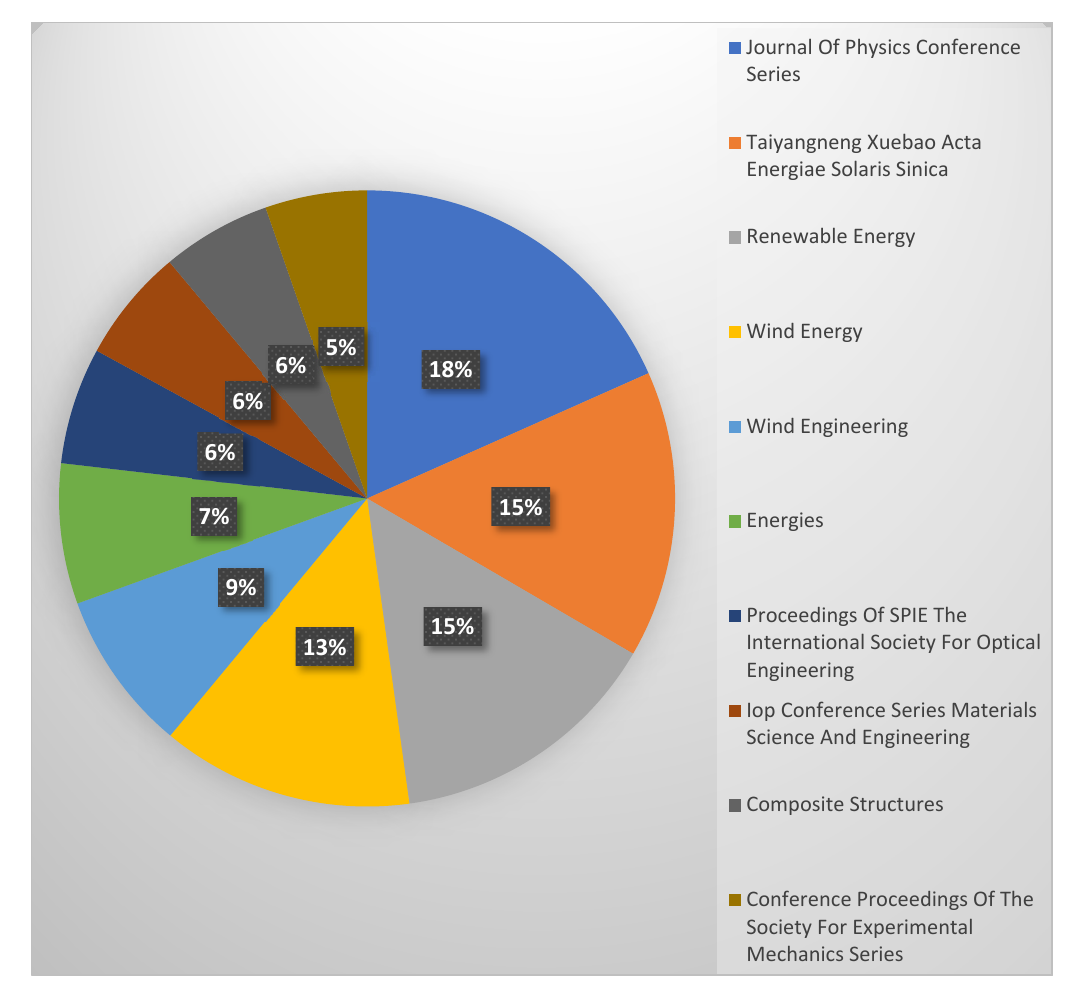
Figure 4. Worldwide top ten journals on optimizing wind turbine efficiency.